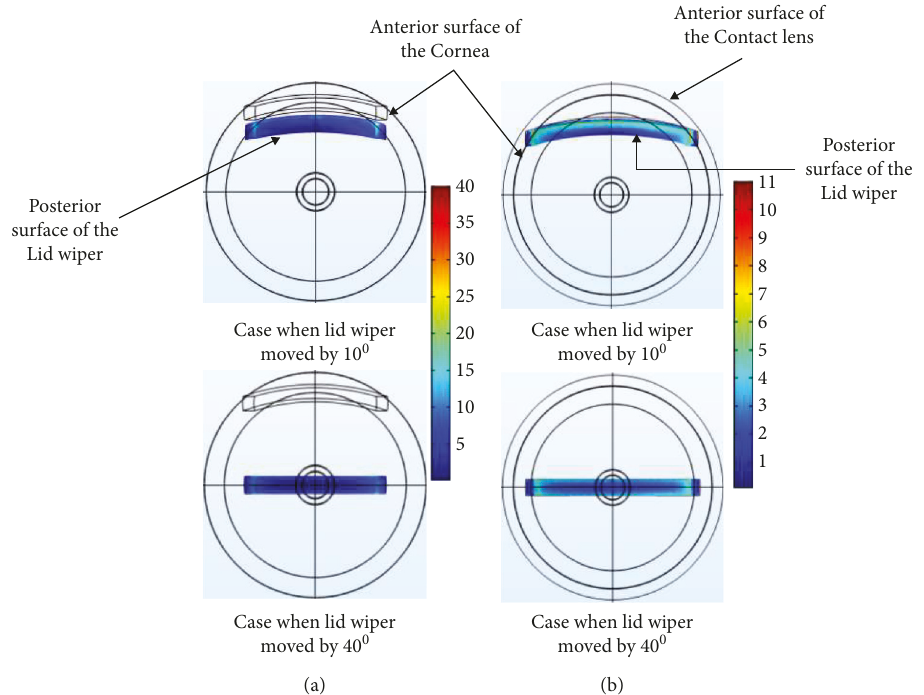
Figure 7: Contour plot of the von Mises stress in the lid wiper during blink without CL (a) and with CL (b) when the lid wiper is moved at superior (10 ° ) and central position (40 ° ) of the cornea (value of the legend shows von Mises stress; unit: kPa). The plots were exported as images from COMSOL Multiphysics v5.2 (https://www.comsol.com), and image collage was made using Microsoft PowerPoint 2019